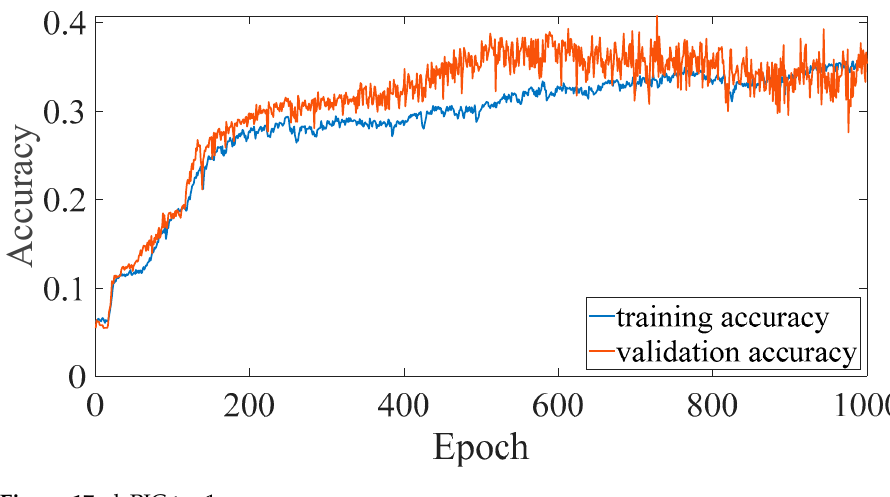
Figure 17. dsPIC top1 accuracy.